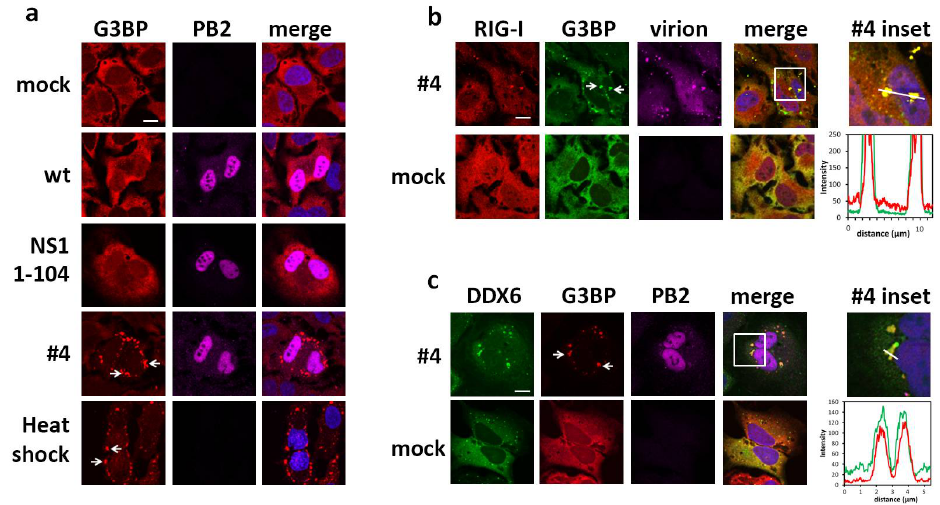
Figure 2. Mutant influenza virus infection induces stress granule association of RIG-I and DDX6 ( a ) HeLa cells were either mock treated, infected with influenza B wild type virus, NS1 mutant viruses 1-104 or #4, respectively, for 16 h, or were incubated at 46 °C for 40 min. (heat shock). Subsequently, cells were fixed and stained with G3BP and influenza virus PB2 specific antibodies. Nuclei were visualized by staining with DAPI. Arrows mark G3BP-positive granules ( b , c ), HeLa cells transfected with Flag-RIG-I and GFP-DDX6 were mock treated or infected with NS1 mutant #4 virus. Sixteen hours post infection, cells were fixed and stained for RIG-I, DDX6 and with antibody directed against influenza B virions ( b ) or PB2 ( c ). Images were analyzed by confocal microscopy. Arrows mark G3BP-positive granules in which also RIG-I ( panel b ) or DDX6 ( panel c ) were detected. The square area of the inset is digitally magnified on the right hand side (inset). The intensity profiles of the green and red channels are shown on the bottom. Scale bar, 10 μm.